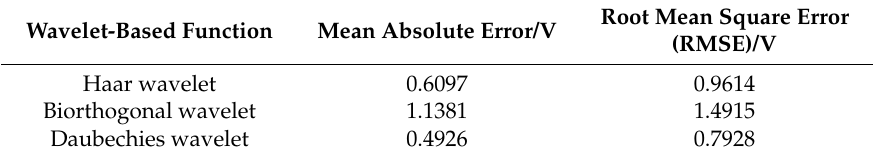
Figure 10. Comparison of time-domain waveforms before and after modeling with the Daubechies wavelet. The results are shown in Table 1. Table 1. The comparison of the predicted error for each wavelet-based function modeling